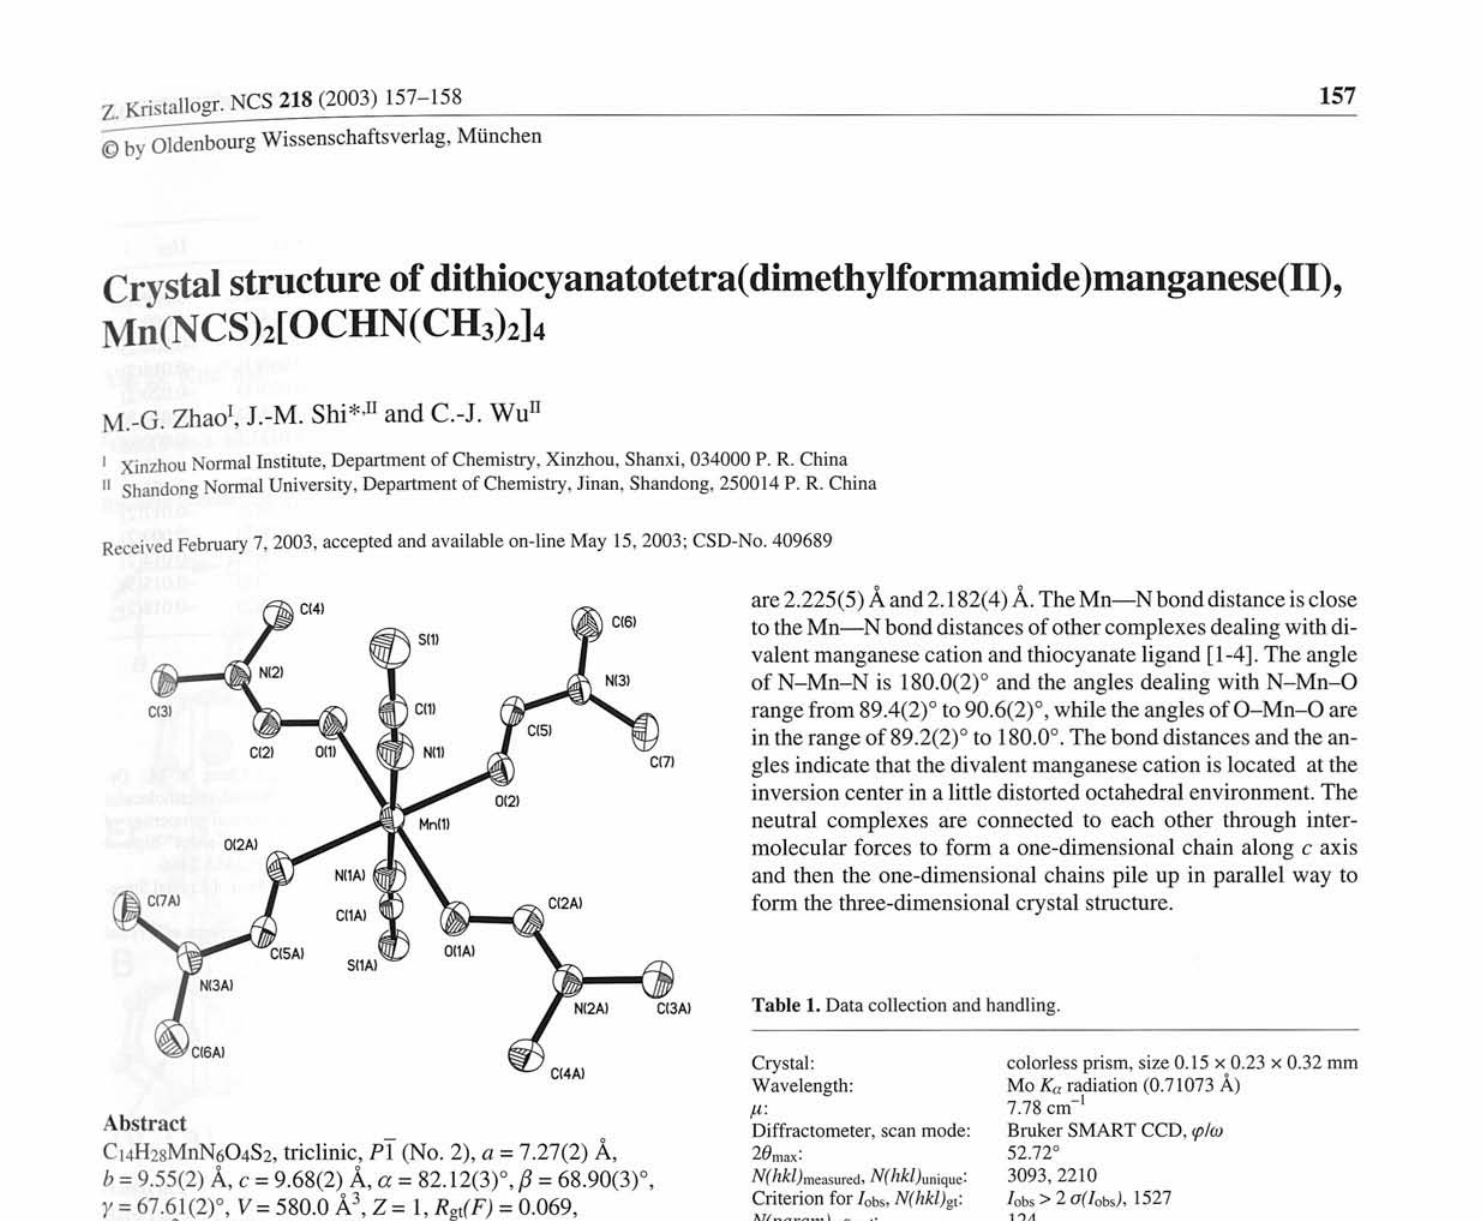
Table 2. Atomic coordinates and displacement parameters (in